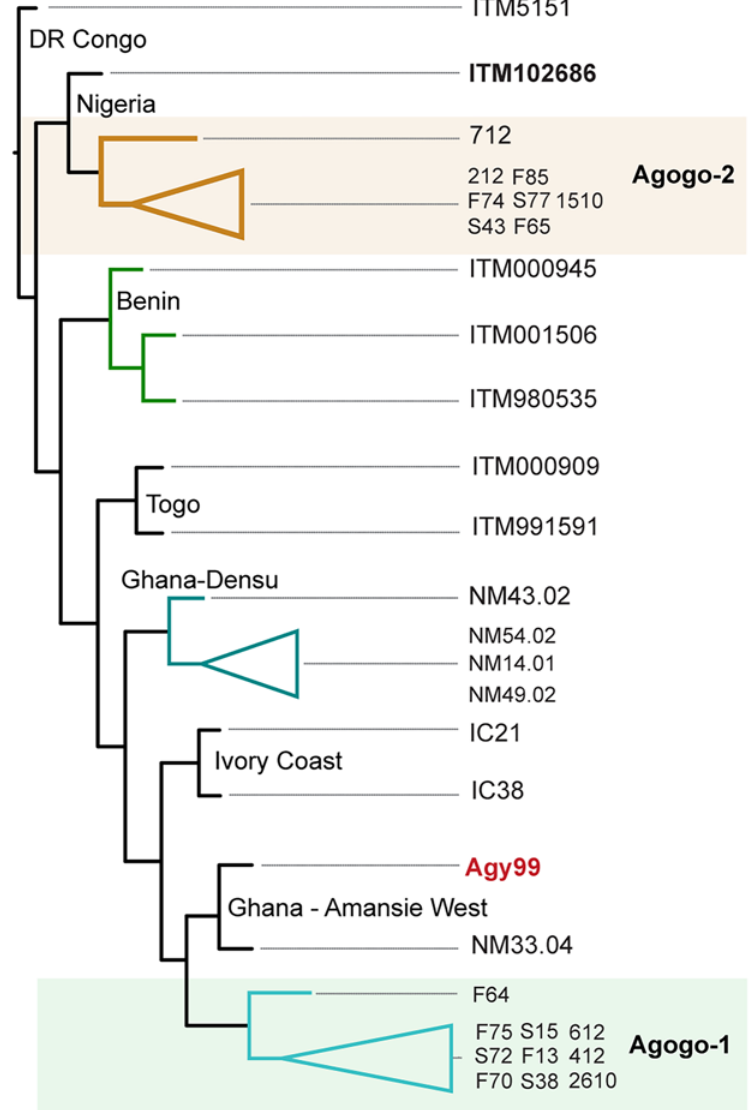
ulcerans Agy99 reference genome. The alignment file from pairwise comparisons of the resulting 320 variable nucleotide positions was used as input for RaxML. Nodes with less than 70% bootstrap support (1000 replicates) were